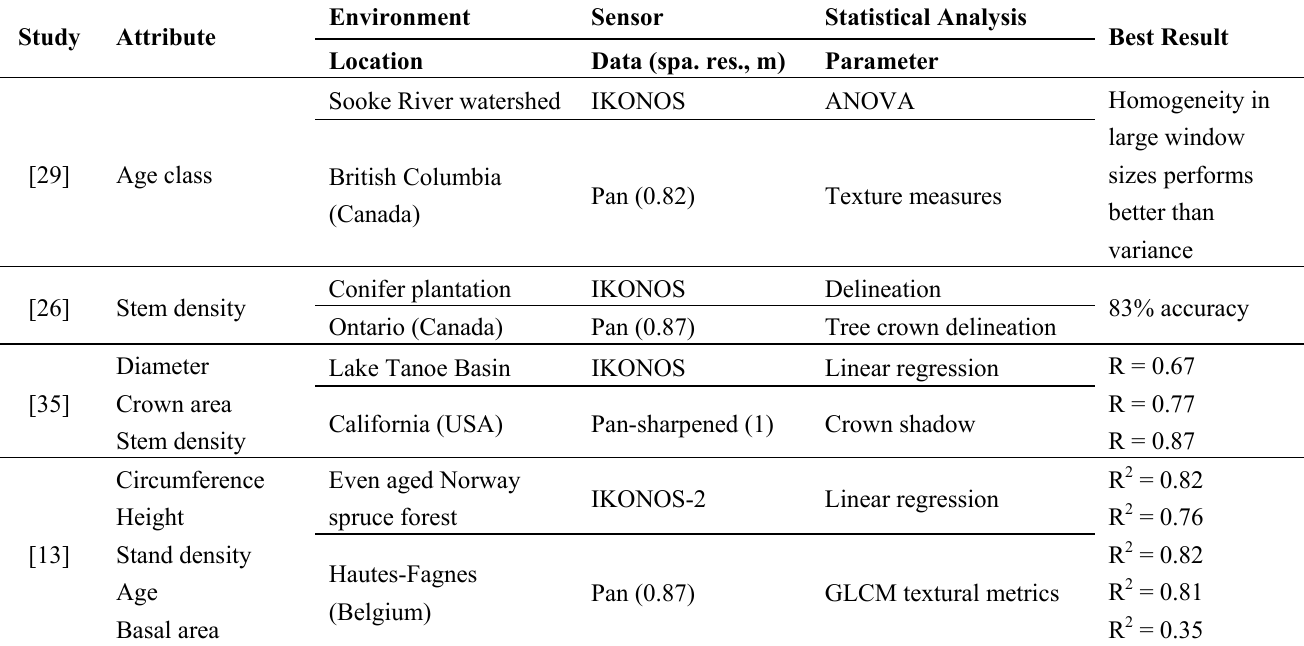
Table 1. Studies employing satellite HSR imagery for estimation of forest structural